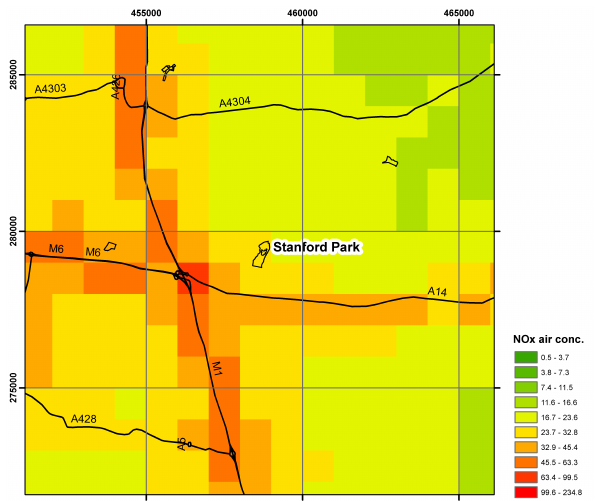
Fig. 3b. NO x air concentrations at Stanford Park SSSI (µgm − 3 ) with 5km grid